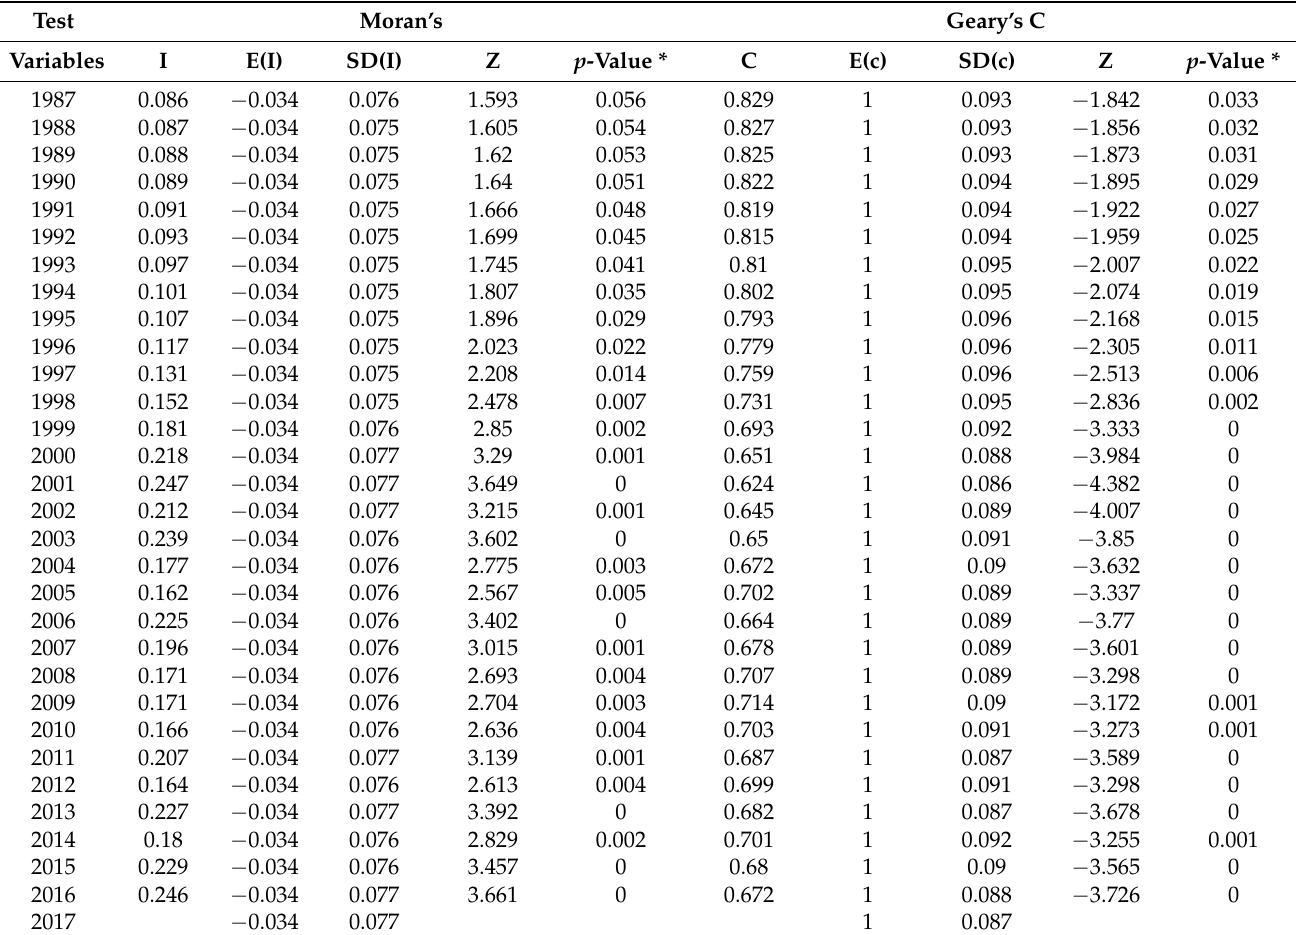
Table 1. Global spatial correlation test results.